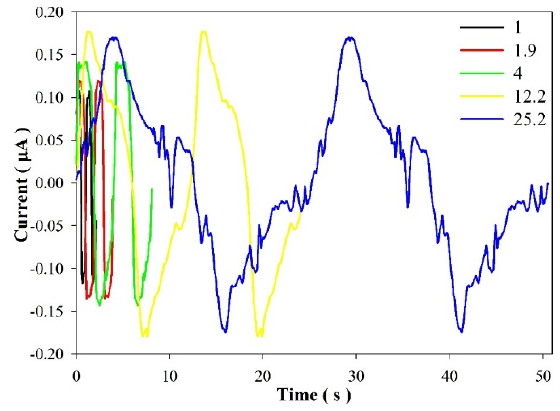
Figure 9. Relationships between the current and time at five periods of 1 s, 1.9 s, 4 s, 12.2 s and 25.2 s under the commercial PZT pyroelectric cell used.